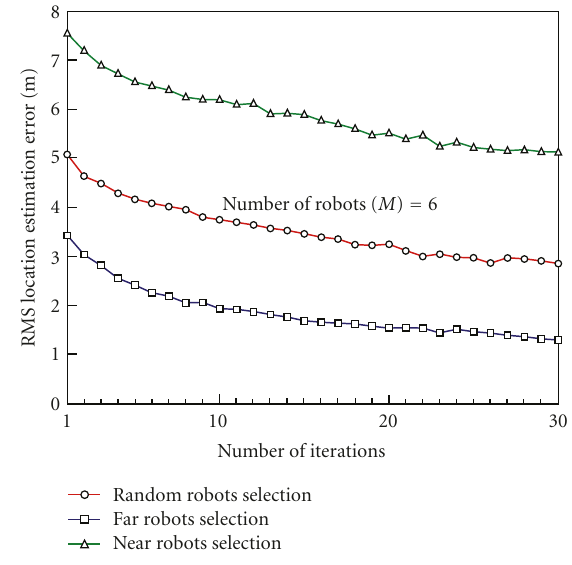
Figure 5: RMS location estimation error for individual robots. Figure 6: E ff ect of robots selection in location